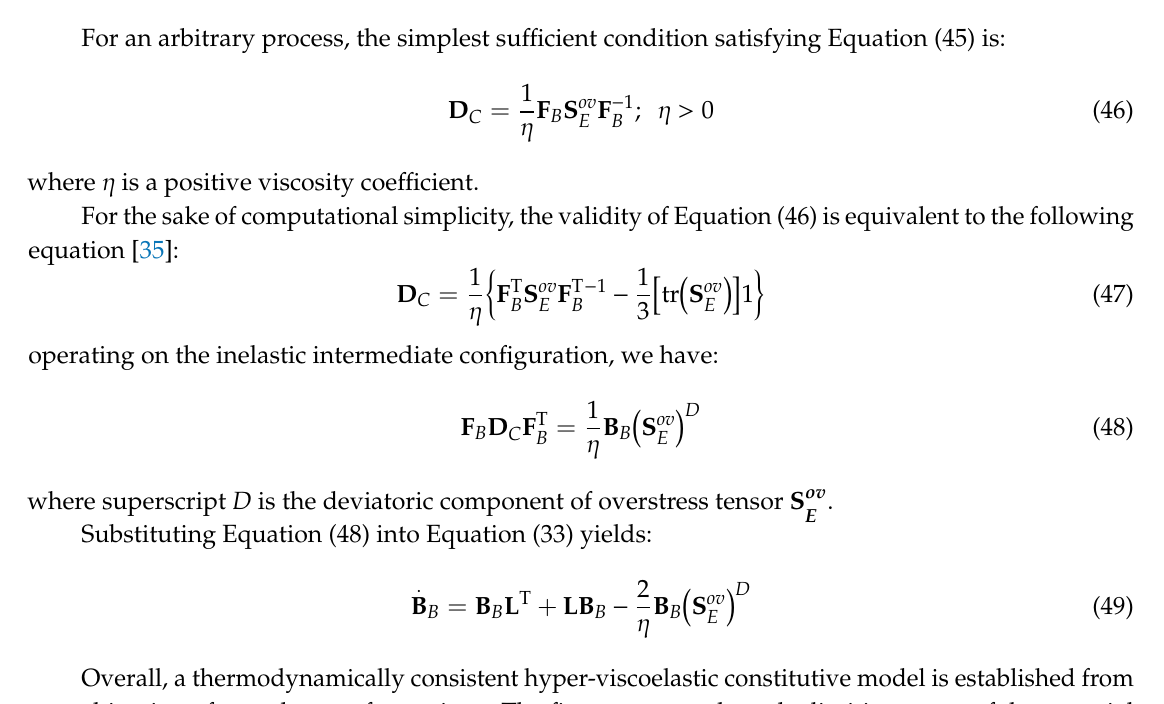
( b ) Elevation view Figure 6. Geometrical sizes of the filled rubber and steel block. (unit: mm). As presented in Figure 7, a servo-hydraulic MTS 831 elastomer testing machine was employed to provide required loading schemes and measure the corresponding shear force. The quadruple-lap shear specimen was mounted on the apparatus by the upper and lower grips, specified displacement was applied at the top steel block to allow it move freely in the vertical direction with a wide range of strain rates from 0.08 s -1 to 12.0 s -1 . The filled rubber deforms under simple shear deformation while the steel blocks are assumed to be undeformed in the tests. In order to remove the Mullins effect and obtain a relatively stable state of stress–strain curves of the specimens, they were subjected to ten cycles with a maximum shear strain of 200% before the formal tests. All the tests were performed at room temperature.